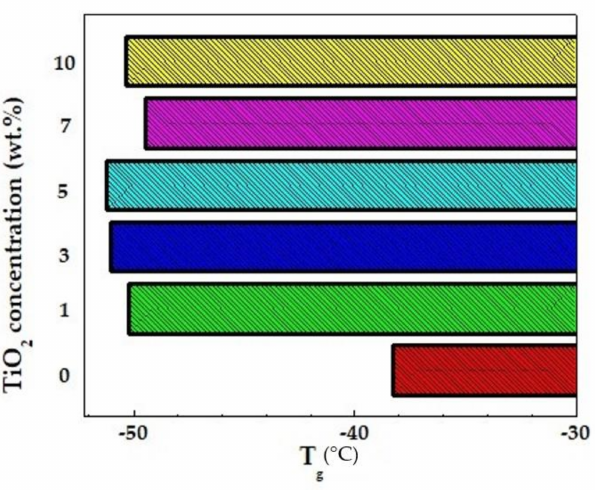
Figure 5. T g ( ◦ C) of the NCPE systems vs the TiO 2 content. Prepared from data in